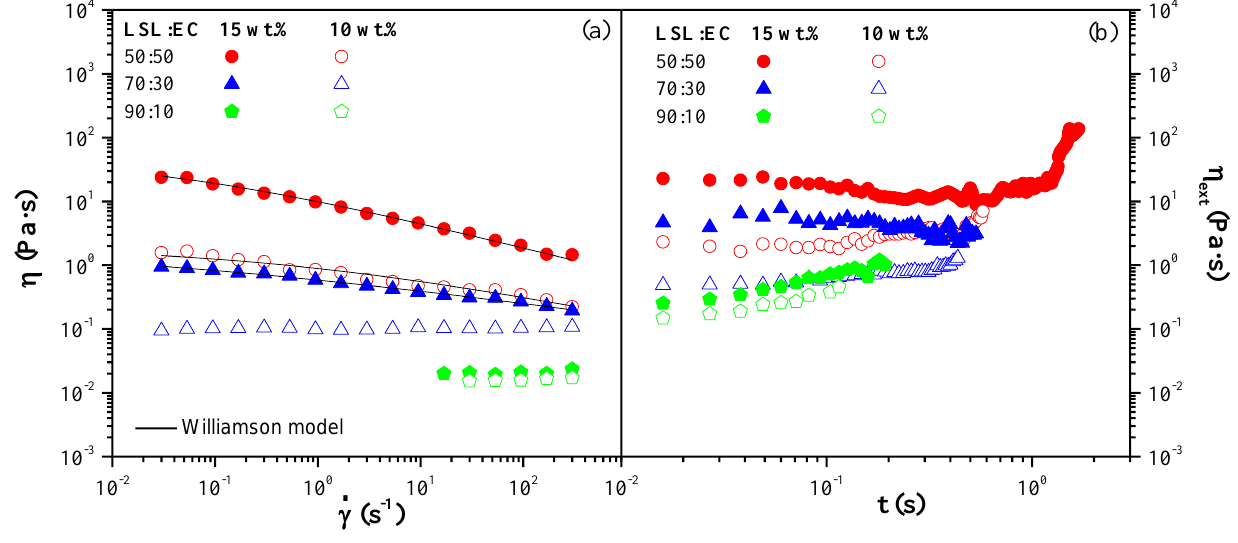
Figure 1. ( a ) Viscous flow curve of LSL:EC solutions in DMAc:THF to 15 and 10 wt.% total concen- tration. Solid lines represent fits to the Williamson model with the parameters given in Table 1 and ( b ) Extensional viscosity as a function of time.